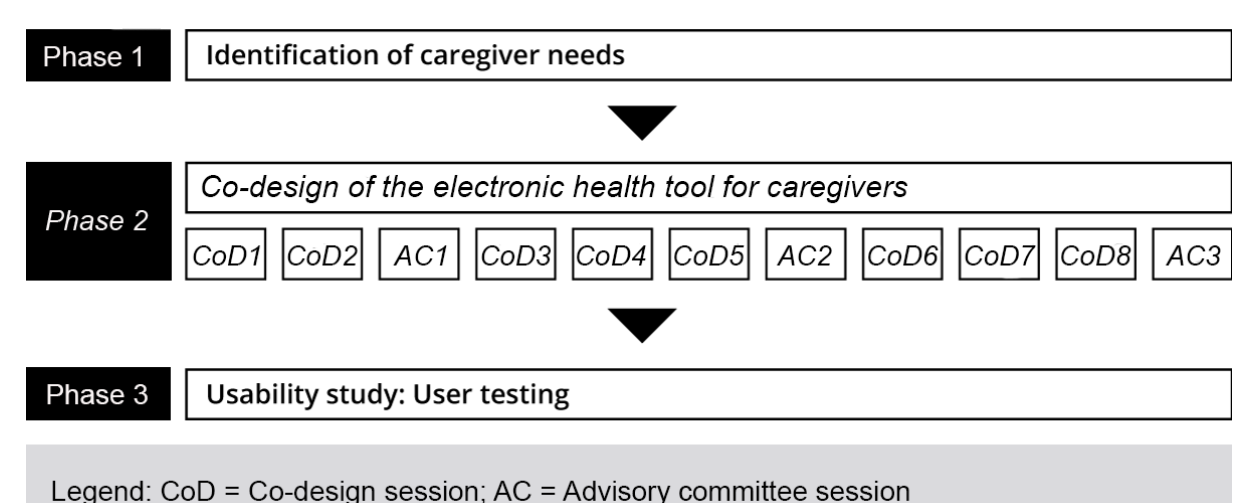
Figure 2. Design Phase of the overall